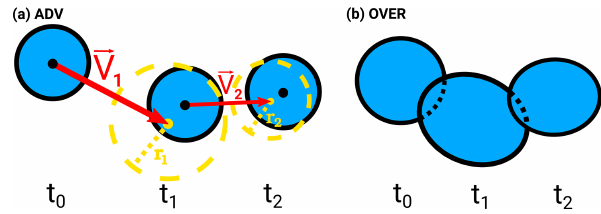
Figure 2. Schematic illustrating the (a) ADV and (b) OVER algo- rithms. In ADV, the red vectors (emanating from the cell’s centre of mass) represent the estimated displacement of the convective cell based on the steering flow. The yellow dashed circle represents the search area, with radius r , in which the displaced cell is sought. The search radius is proportional to the magnitude of the displacement vector. In OVER, the area between the dashed and solid lines marks the cell’s area of overlap at consecutive time steps. See also Brisson et al. (2018) for a schematic of the Brendel et al. (2014) algorithm.